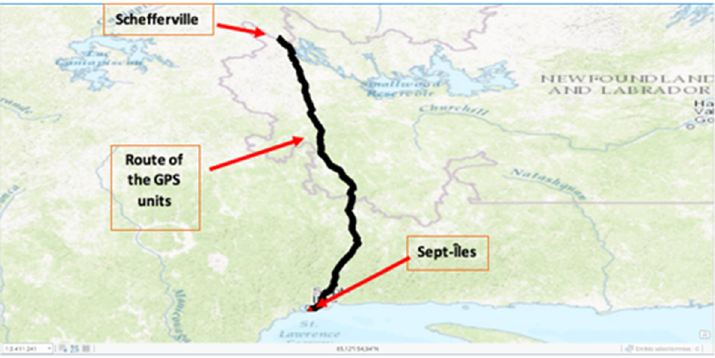
Figure 6. GPS coordinates mapping between Sept-Îles and Schefferville (isolated environment).